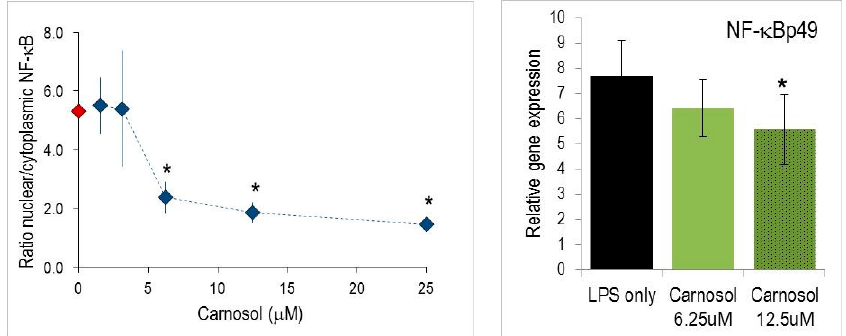
Figure 5. Carnosol altered the NF-kB signaling pathway. Left panel: Nuclear translocation of NF- κ B. Chondrocytes (NHAC-kn) were pre-incubated with carnosol for 1 h and stimulated with IL-1 β for 20 min. The relative nuclear immunofluorescence is indicated on the y-axis (see Materials and Methods for details). Asterisks indicate statistically significant differences between the different treatments (* p < 0.05). Right panel: Carnosol reduces expression of transcription factors of the NF- κ B pathway. Cells were stimulated for 4 h and gene expression levels determined by RT-PCR (* p < 0.05).